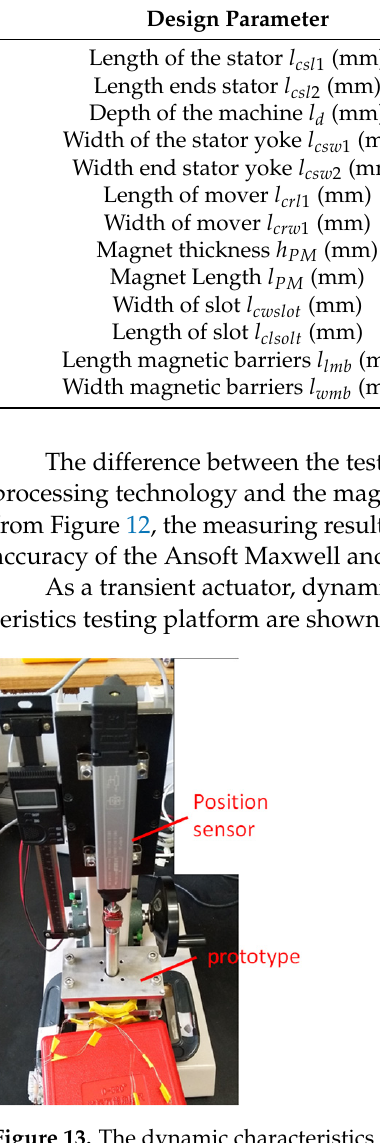
( b ) Figure 14. The closing dynamic characteristics of the prototype. ( a ) The mover position in closing process. ( b ) The current in closing coil. In dynamic characteristics, the closing and opening coil is connected to 70 v DC voltage source. In Figure 14a, the mover spent 14 ms from opening position to closing position. The closing current lasts a long time due to limited experimental conditions. We can’t turn off the power right away. However, the closing current does not affect the closing dynamic characteristics of the prototype. The rubber band has added in proto- type to obtain the opening dynamic characteristics. The position sensor output voltage range is from 0 v to 20 v, measuring range is from 0 mm to 75 mm. According to the position sensor output signal in Figure 14a, the mover position can be calculated as dropout voltage. Comparing with Figures 12, 14 and 15, the measuring static performance results agree with the simulation results and dy- namic experiments successfully complete the opening and closing process, which con- firm the accuracy of dynamic simulation and the above analysis. Therefore, the perfor- mances of proposed permanent magnet actuator are sufficient for potential applications. However, the dynamic characteristics of the full-scale ABSMPMA will be studied in the near future owing to limited experimental conditions.